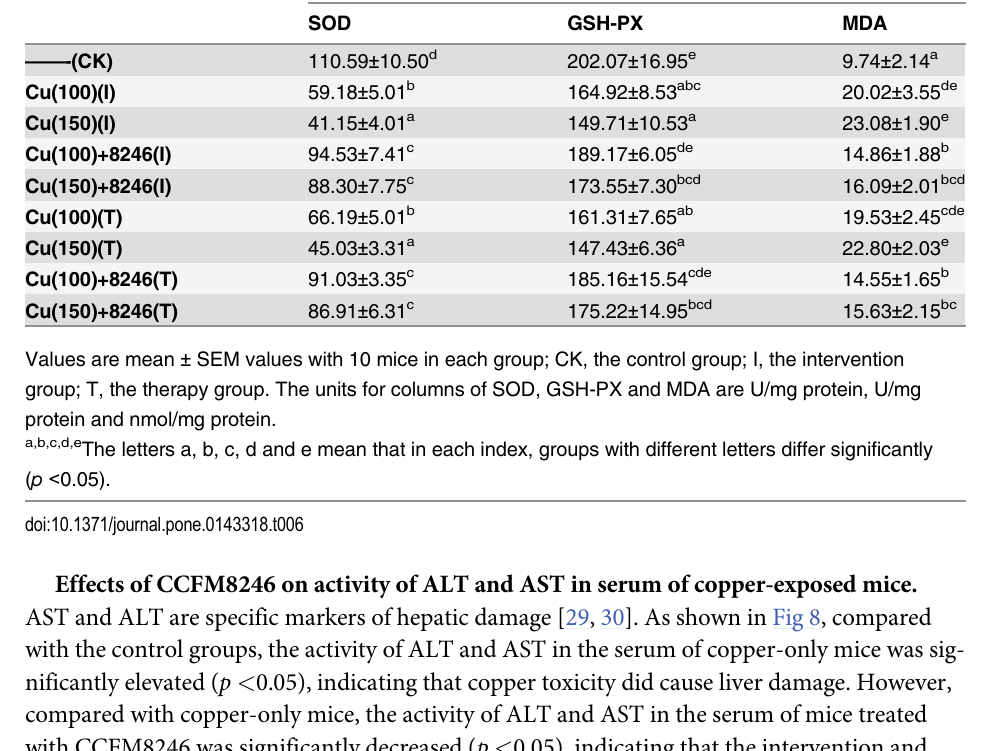
Table 6. Effects of CCFM8246 treatment on the activity of SOD, GSH-PX and level of MDA in the livers of mice. Treatment Oxidation stress indices